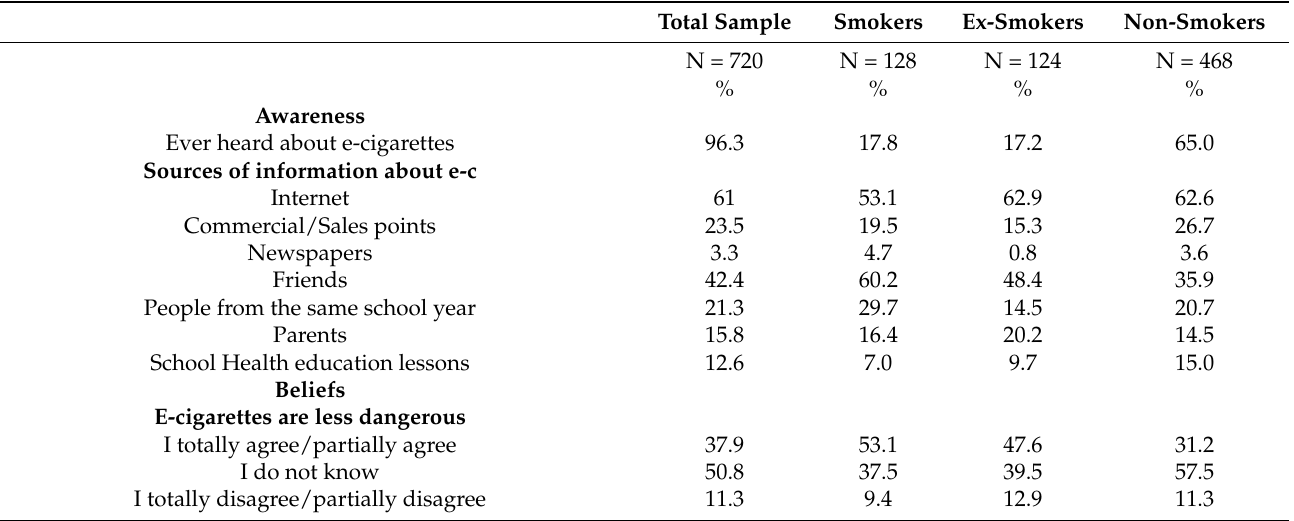
Table 1. Opinions, behavior, and source of information regarding e-cigarette use, intention to use e-cigarettes, intention to quit traditional